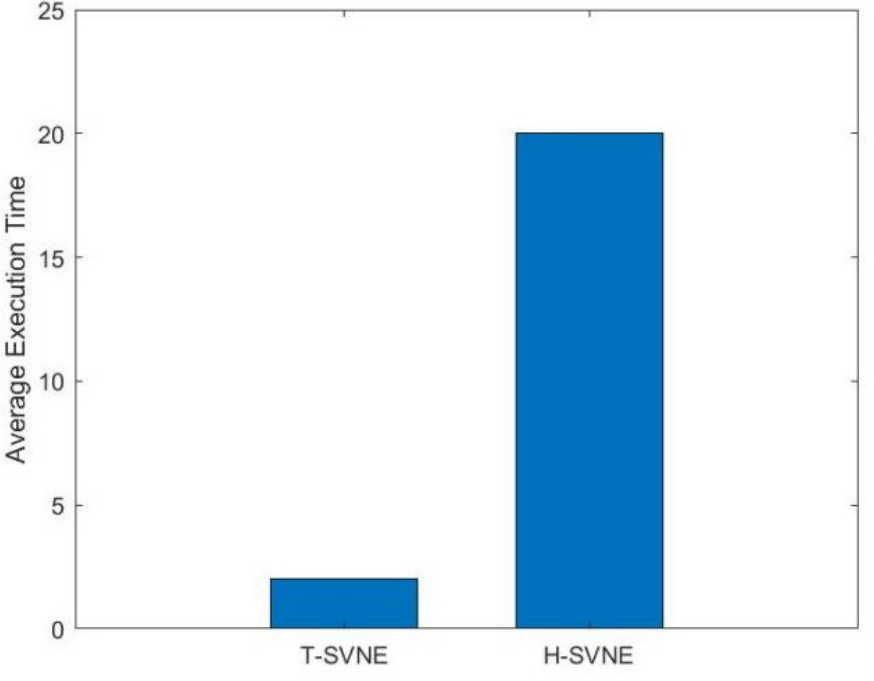
Figure 7. The average execution time.